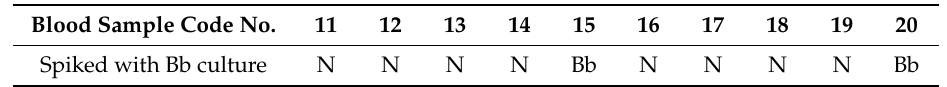
Table 1. Decoding of the blinded samples by NYS